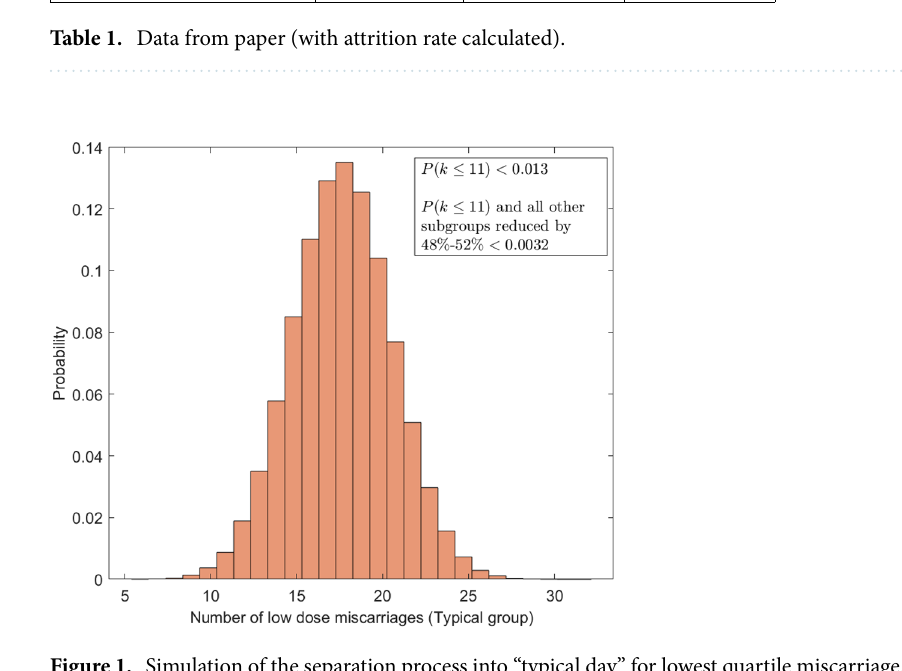
Figure 1. Simulation of the separation process into “typical day” for lowest quartile miscarriage. Level of attrition in this subgroup is significantly more than would be expected by chance. See text for